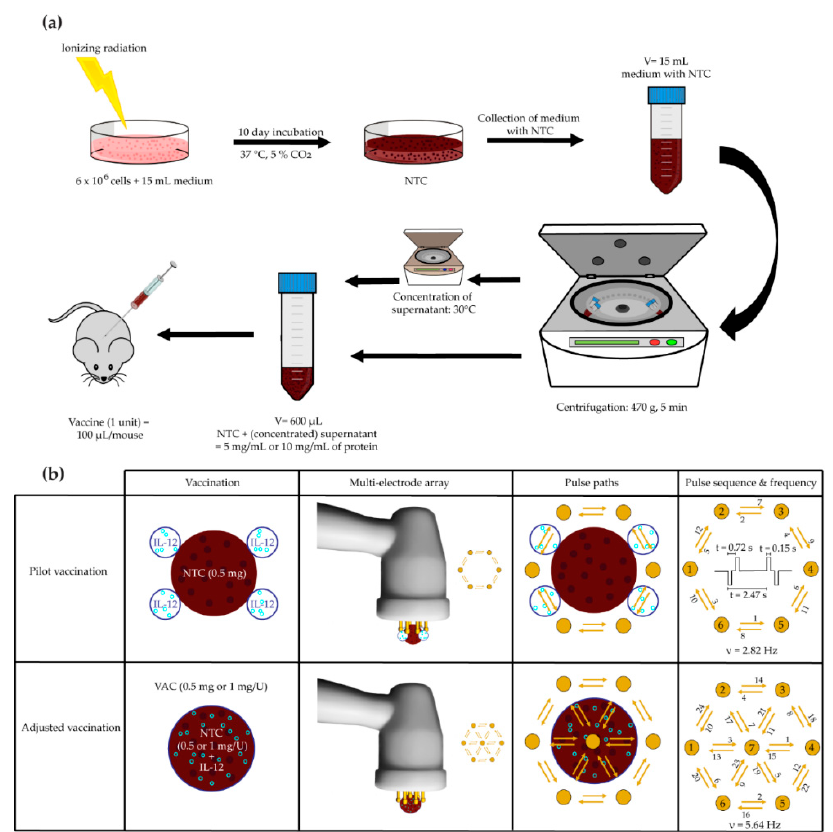
Figure 1. Overview of the tumor vaccine preparation procedure and application. ( a ) Tumor vaccine preparation. ( b ) Tumor vaccine application. NTC = non ‐ viable tumor cells; IL ‐ 12 = interleukin ‐ 12;